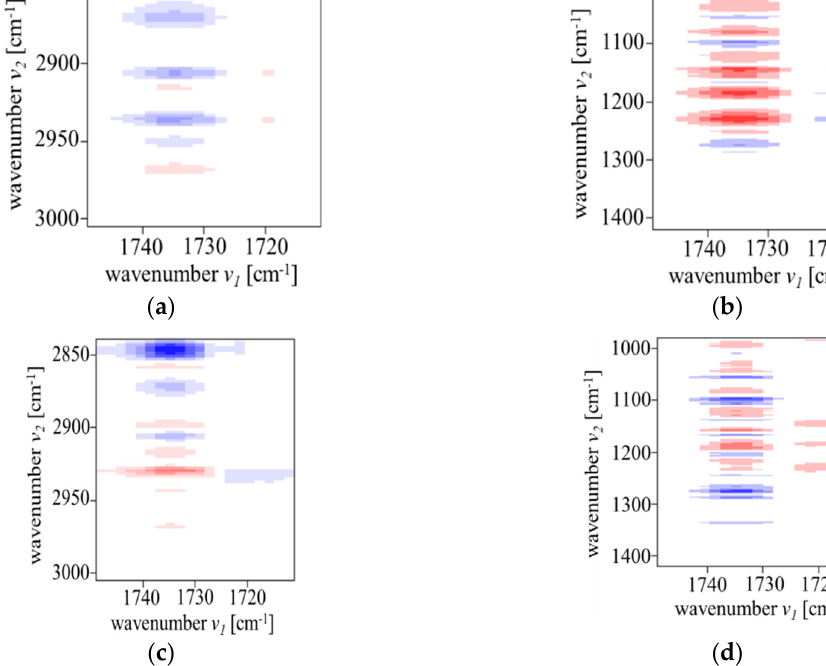
Figure 7. 2D-COS correlation ( a , b ) synchronous and ( c , d ) asynchronous maps of 3F7HPhH7 in the